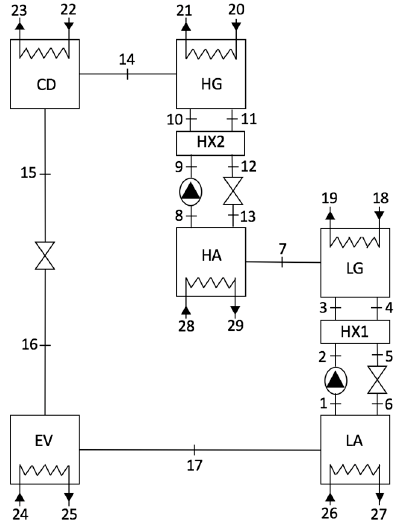
Figure 2. Scheme of the half absorption chiller. HG: high generator; LG: low generator; HA: high absorber; LA: low absorber; HX: heat exchanger; CD: condenser; EV: evaporator.